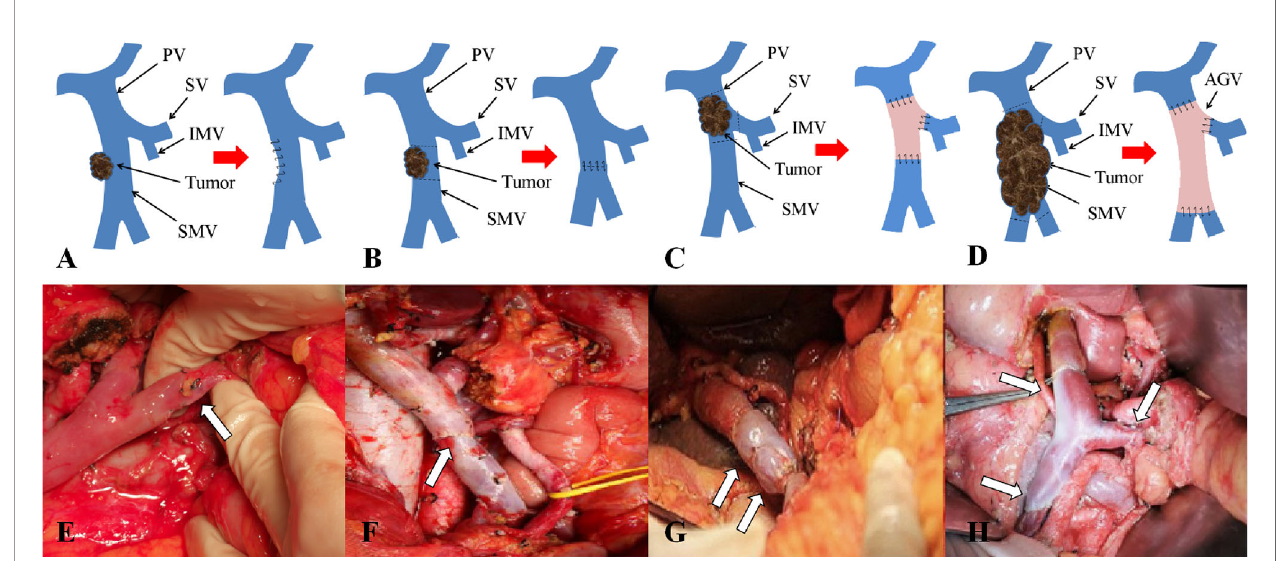
FIGURE 3 | Chaoyang classi fi cation and management of venous invasion of borderline resectable pancreatic cancer. (A, E) Tumor invades superior mesenteric vein with wedge anastomosis; (B, F) Tumor invades superior mesenteric vein with end-to-end anastomosis; (C, G) Tumor invades portal vein with segmental vascular replacement; (D, H) Tumor invades the con fl uence of portal vein with branch vascular